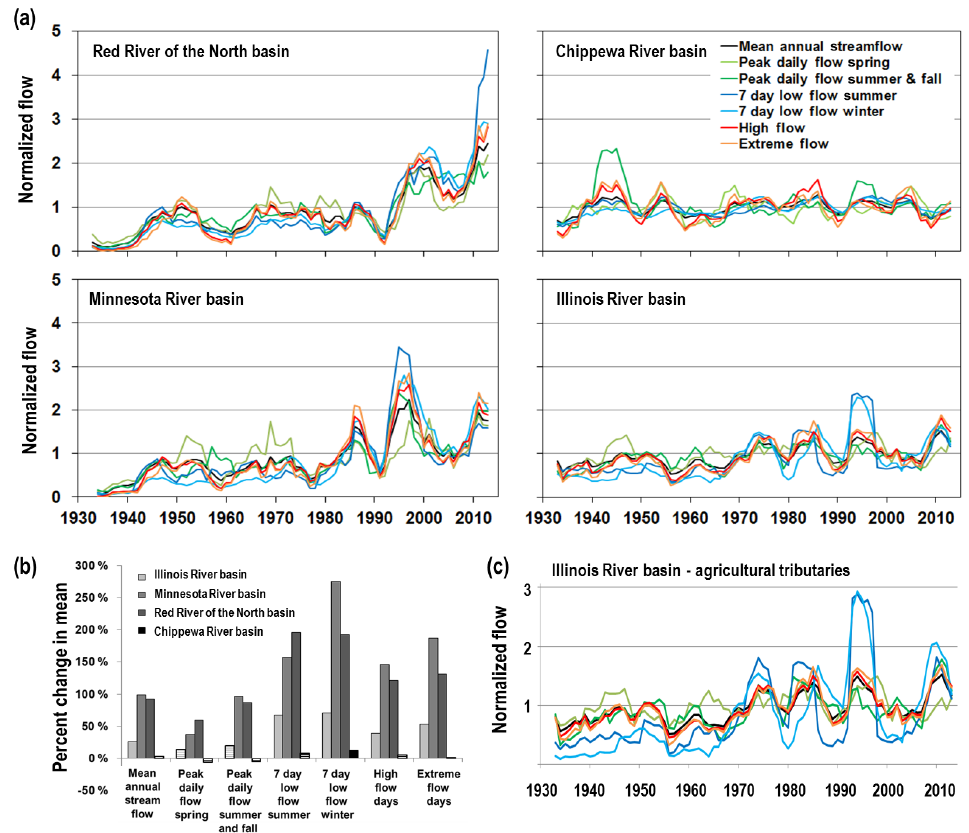
Figure 5. (a) Seven normalized streamflow metrics presented as 5-year running averages based on annual and daily gauge analysis for the Red River of the North basin, 22 gauges; Chippewa River basin, 9 gauges; Minnesota River basin, 12 gauges; and Illinois River basin, 20 gauges. (b) Percent change in flow metric mean between 1934–1974 and 1975–2013. Solid bars indicate significant increases in means ( α = 0.05). (c) Streamflow metrics for seven Illinois River basin tributary gauges that are predominately agricultural and not influenced by major dams. Annual flow metrics normalized by the 1950–2010 mean. Refer to Table 1 for gauge station